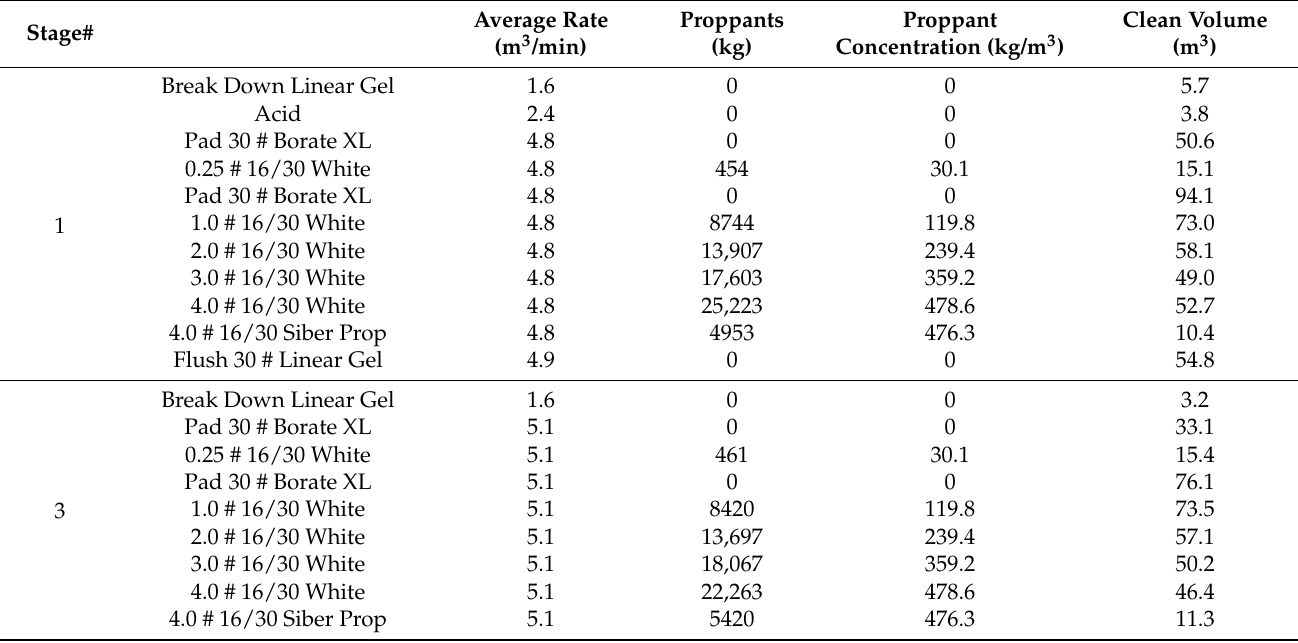
Figure 4. Completion design of SANDY03. Table 2. Stage #1 pumping design for hydraulic fracturing